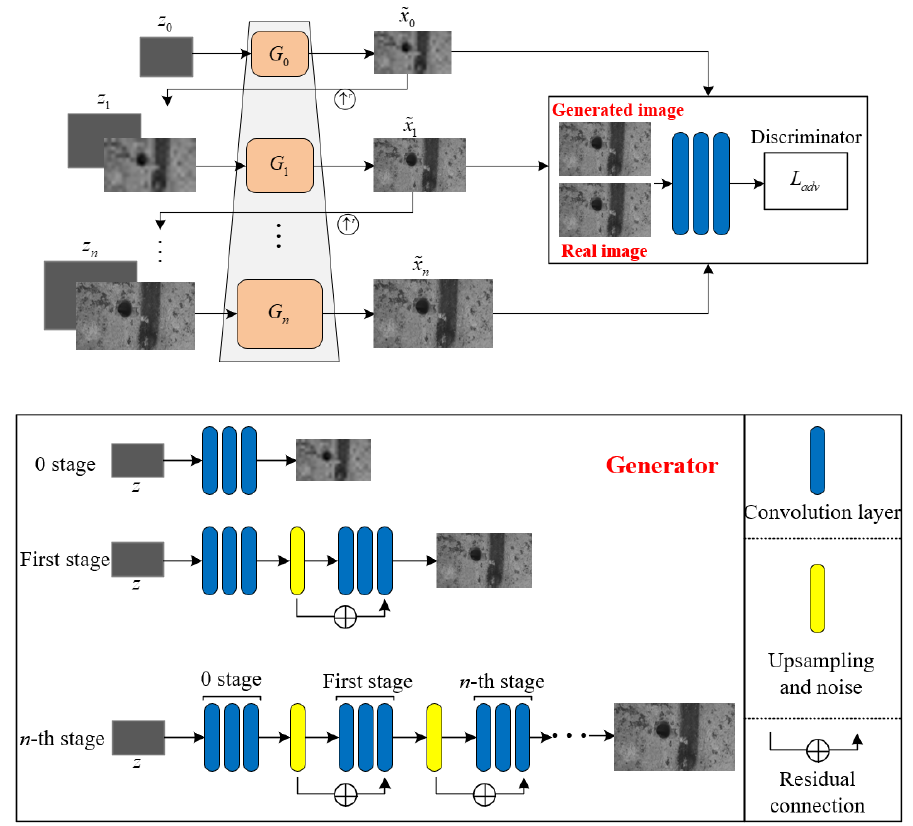
Figure 3. Generation model of a pressure relief hole image based on improved SinGAN.